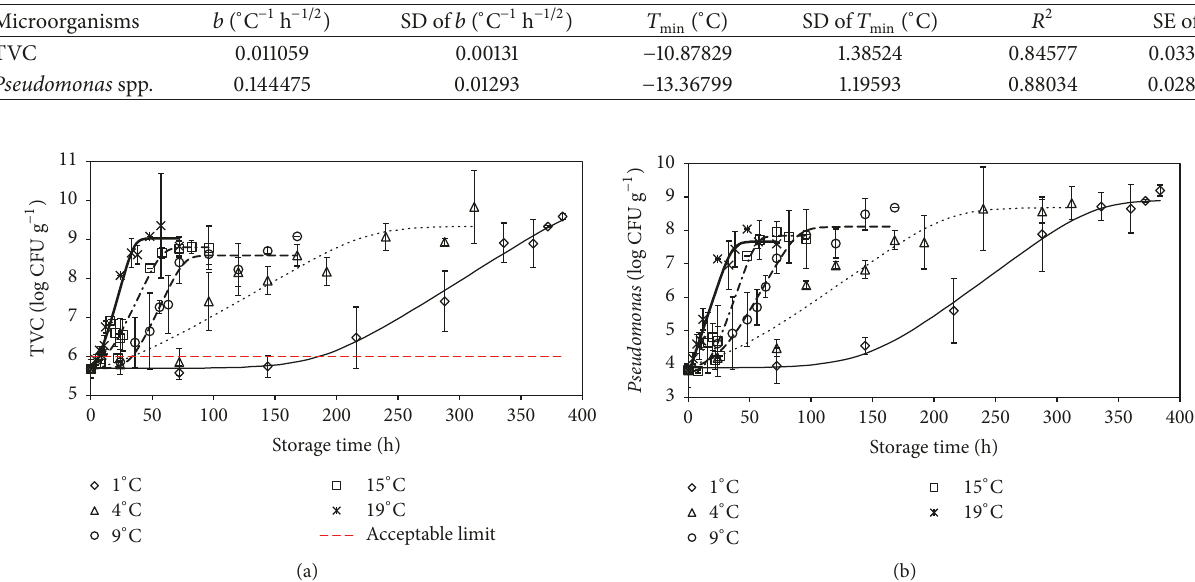
Table 2: Estimated parameters with standard error (SD) of the square root model for TVC and Pseudomonas growth in Pangasius fillets stored at low temperatures.